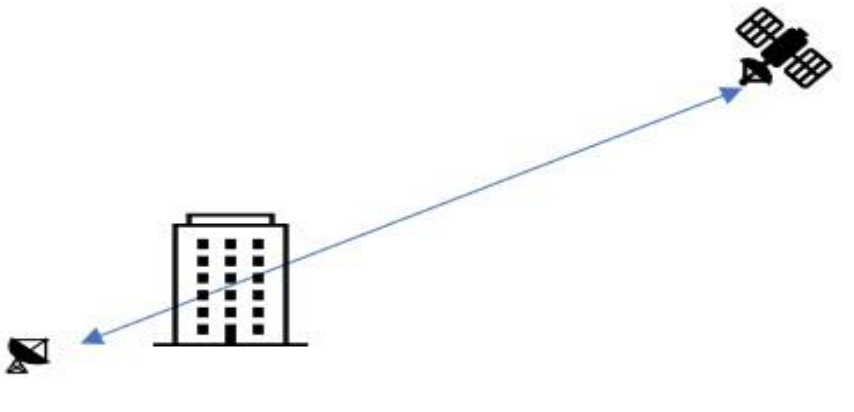
Figure 7. Building shadowing loss.